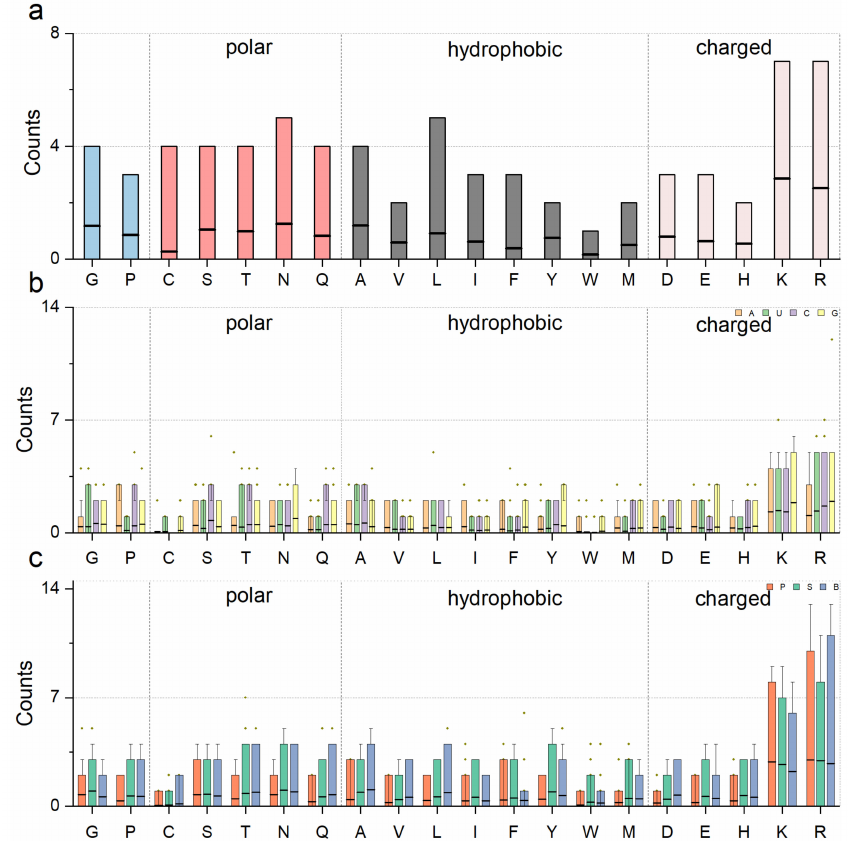
Figure 5. ( a ) The average frequency of the amino acids located at the RNA–protein interface. ( b ) The average contribution of the amino acids interacting with nucleotides. ( c ) The average contribution of the amino acids interacting with RNA backbone (phosphate and sugar) and bases. Boxes in ( a – c ) represent the 90% core distribution (ranging from the 5th to 95th percentile). The black lines on the box represent the average